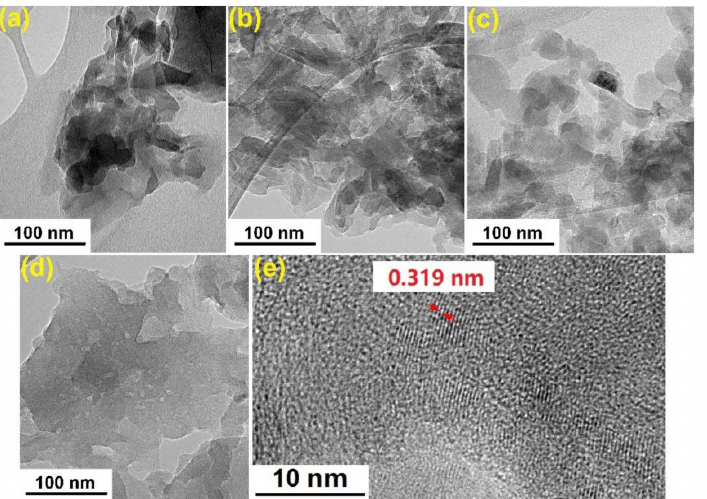
Figure 6. TEM images of ( a ) GCN-B; ( b ) GCN-450; ( c ) GCN-500; ( d ) GCN-550; ( e ) lattice spacing of